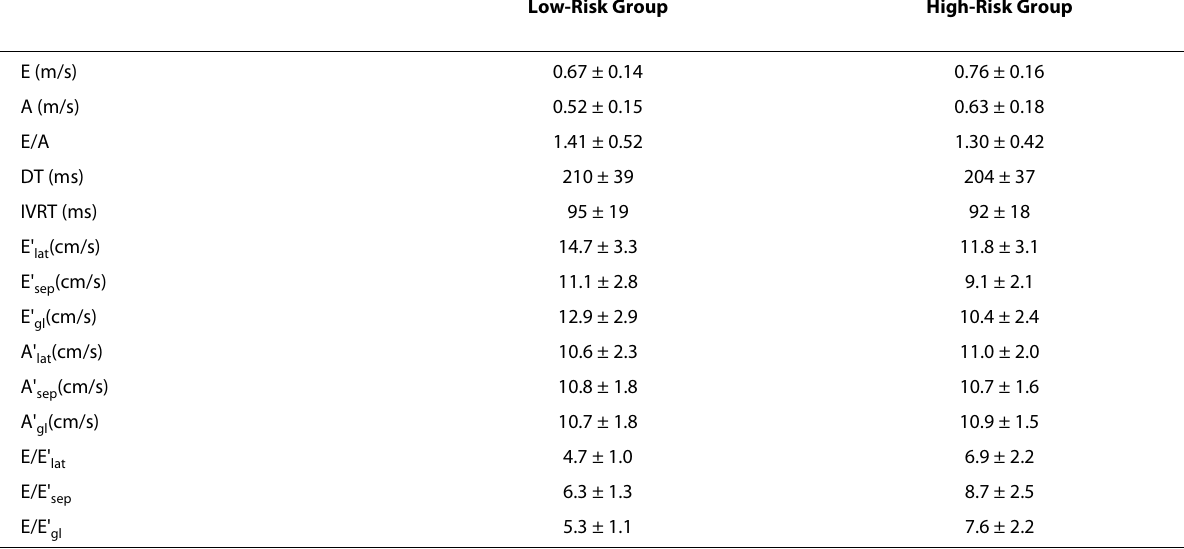
Table 4: Descriptive statistics for primary echocardiographic endophenotypes in